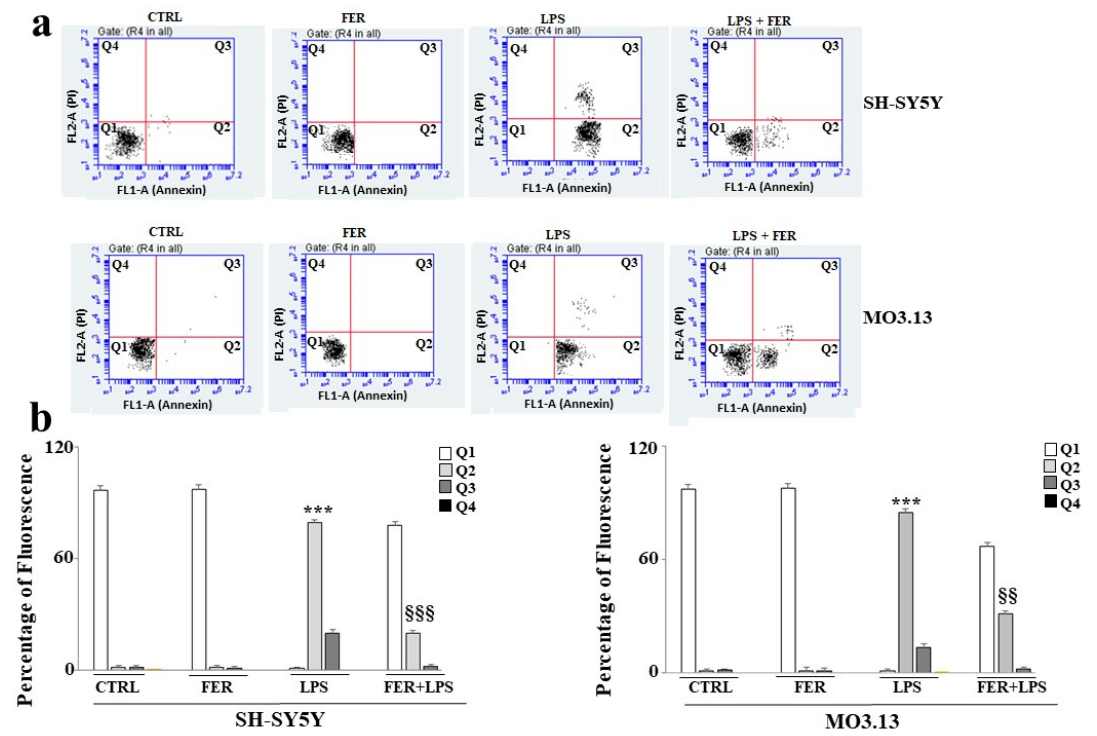
Figure 4. Pretreatment with FER reduces apoptotic death induced by treatment with LPS. To assess whether treatment with LPS resulted in apoptotic or necrotic death and whether FER pretreatment could prevent LPS-induced death, we studied neurons and oligodendrocytes, as shown in Figure 4 (panel ( a )), where each treatment is represented by a dot plot divided into 4 quadrants (Q1, Q2, Q3, and Q4). Q1 refers to Annexin V-negative/PI-negative cells. Q2 refers to Annexin V-positive/PI-negative cells (apoptosis). Q3 refers to Annexin V-positive/PI-positive cells. Q4 refers to Annexin V-negative/PI-positive cells (advanced necrosis). A representative experiment from the three independent experiments is shown. Panel ( b )) shows the quantification of the four quadrants of each dot plot for the data obtained from both neurons and oligodendrocytes. Three independent experiments were carried out, and the values are expressed as the mean ± standard deviation (sd). *** denotes p < 0.001 vs. the control; §§ denotes p < 0.01 vs. LPS; §§§ denotes p < 0.001 vs. LPS. Analysis of Variance (ANOVA) was followed by a Tukey–Kramer comparison test.